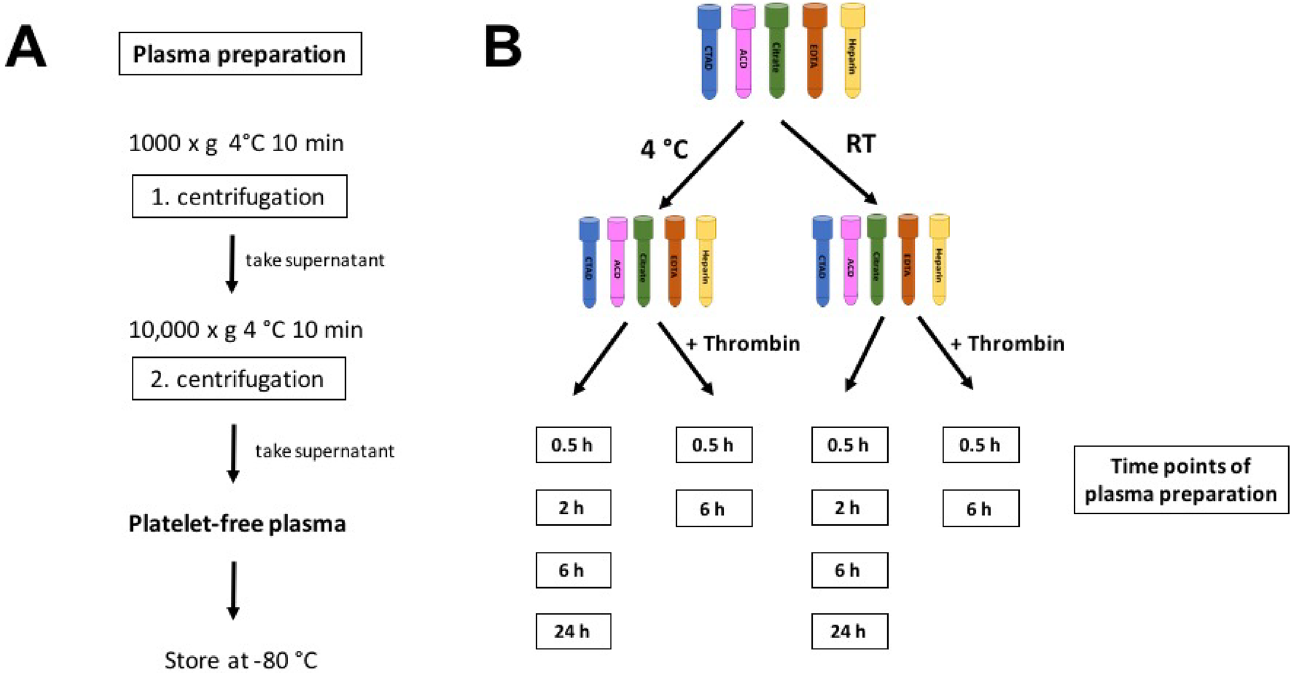
Fig 1. Experimental set-up to compare the effect of different anticoagulants on plasma levels of platelet-stored factors. (A) Plasma preparation. Anticoagulated blood of 8 healthy volunteers was centrifuged at 1,000 x g and 4˚C for 10 minutes. Supernatants were transferred to new tubes and centrifuged at 10,000 x g and 4˚C for 10 minutes to generateplatelet-freeplasma. Supernatants of the second centrifugation step were aliquotedand stored at –80˚C until further use. (B) Sampling. Blood of each donor was collectedusing CTAD (blue), ACD (pink), citrate (green), EDTA (red) and heparin(yellow)as anticoagulant. Half of the samples were kept either at 4˚C or at room temperature. Plasma was generatedat 0.5 h, 2 h, 6 h, and 24 h. To analyzethe effect of in vitro platelet activationa subgroupof samples was stimulatedwith thrombin at a submaximal concentration and plasma was generatedafter 0.5 h and 6